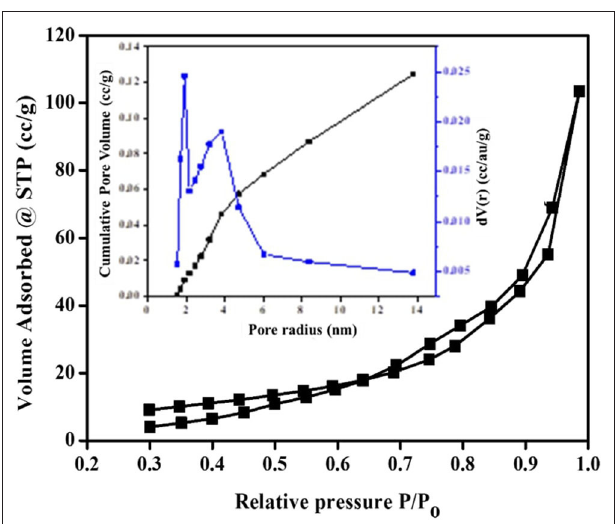
FIGURE 8 | UV-Vis of green TiO 2 NPs.